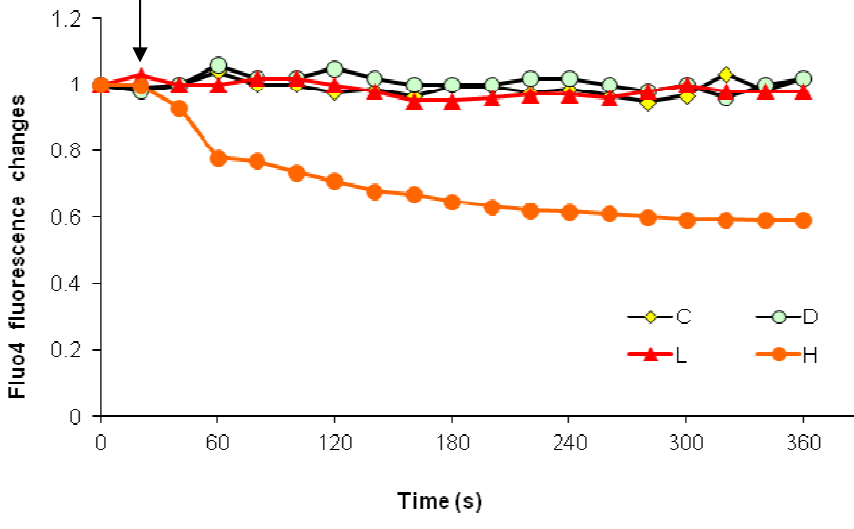
Figure 5. Paclitaxel-induced cytosolic Ca 2+ decrease in Ca 2+ -free medium. The basal Fluo4 fluorescence level of all groups before treatment was similar and was expressed as